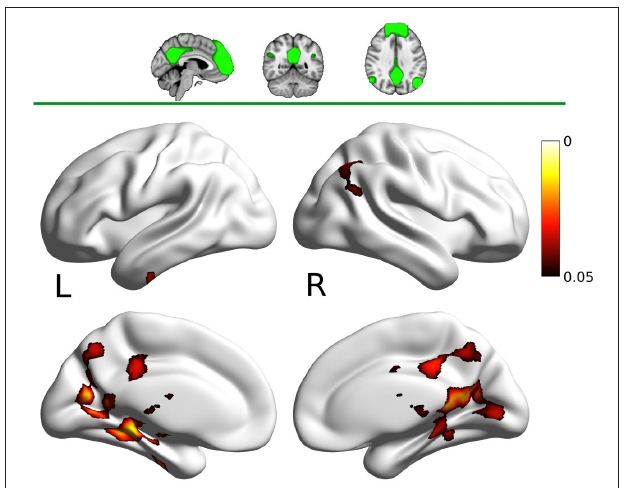
FIGURE 3 | Results for the default mode network (DMN) mask (two dimensional image on top, with mask shaded in green, centered at x = − 4 , y = − 53 , z = − 35 ). Warm colors present the cluster of decreased connectivity in carnosine/anserine subjects (multiple comparison FWE corrected, p < 0.05). Left (L) and right (R) hemispheres are presented separately.